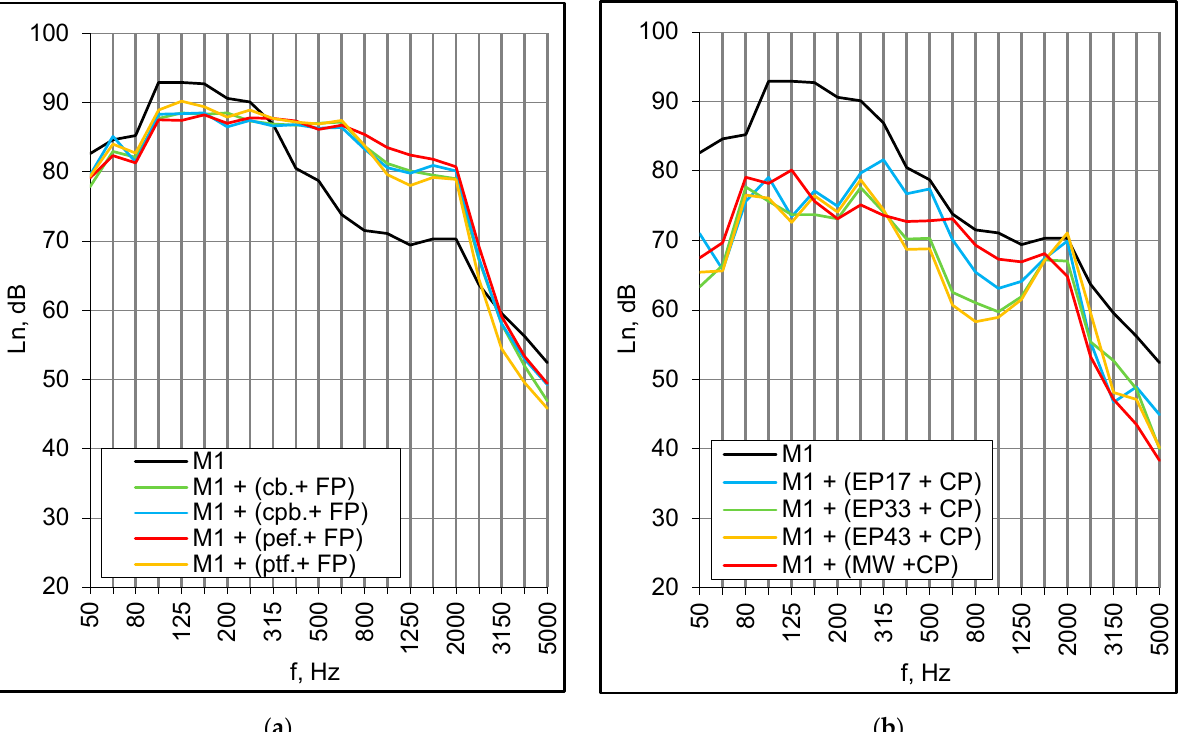
Figure 12. ( a ) M1 panel with floor coverings; floor panels (FP), corkboard, 3 mm (cb.3 mm), corrugated paper board, 3 mm (cpb.3 mm), polyester foam, 5.5 mm (pef.5.5 mm), polyethene foam, 3 mm (ptf.3 mm); ( b ) M1 panel with floating screed: cement plate, 40 mm (CP), E-EPS 17/15 (EP17), E-EPS 33/30 (EP33), E-EPS 43/40 (EP43), mineral wool (MW). Heavy floating screeds consisted of a cement plate, 40 mm thick, positioned succes- sively on: elastic polystyrene E-EPS 17/15, E-EPS 33/30, E-EPS 43/40, and mineral wool